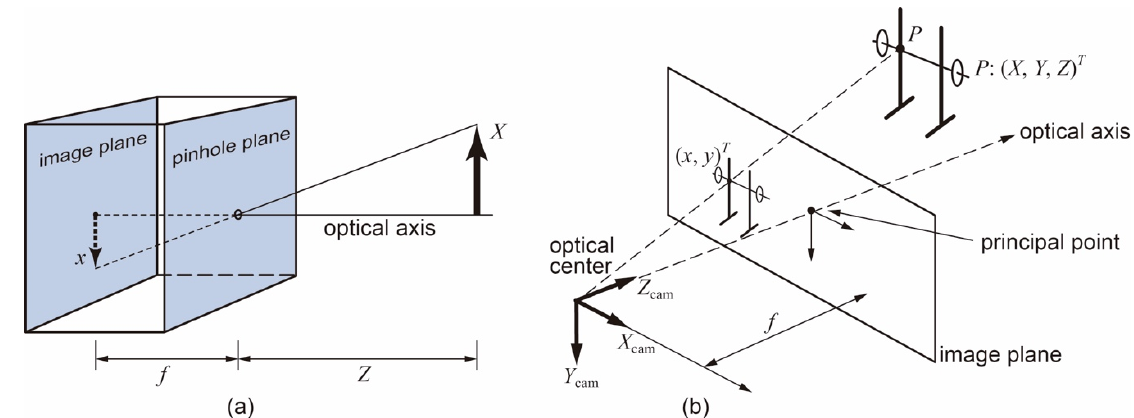
Figure 2. Pinhole camera model used in this study. ( a ) Direct model showing the relationships between inside and outside geometry; ( b ) inverted model defining the geometric relationship between outside coordinates and the corresponding 2D projection onto the image plane.